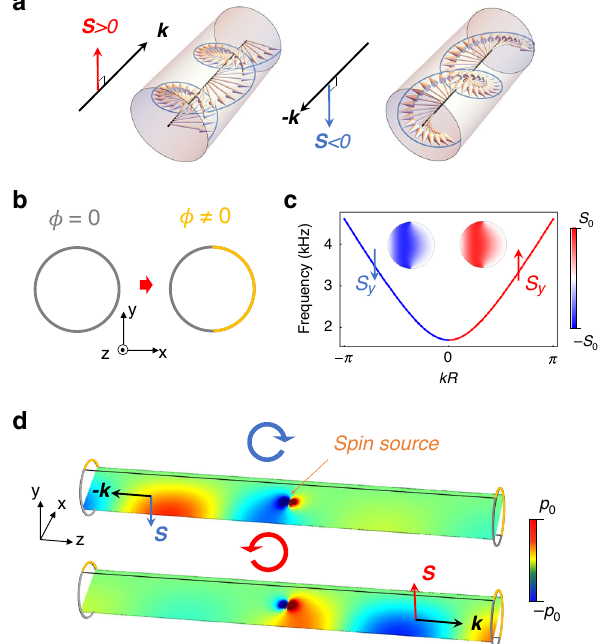
Fig. 1 Spin angular momentum in waveguide with symmetry-breaking boundary conditions. a The schematic description of spin-dependent propagations in waveguide. The circular evolutions of velocity fi elds (Gray arrows) in propagating acoustic waves re fl ect the nonzero transverse spin angular momentum according to the acoustic SAM de fi nition in Eq. (1). b Cross-sectional view of acoustic waveguide with nonsymmetric boundary conditions with different re fl ection phase ϕ ≠ 0. c The spin-resolved dispersion along z -direction. We use the red/blue color to represent the sign of acoustic SAM of eigenmodes S y = ∫ s y d r 2 , red for S y > 0 and blue for S y < 0. The radius of waveguide is R = 4 cm. The re fl ection phase is set as ϕ = π (metasurface boundary). d The selective excitation of these waveguide modes can be realized by exploiting the spin sources (circularly polarized acoustic dipoles) placed in the center of